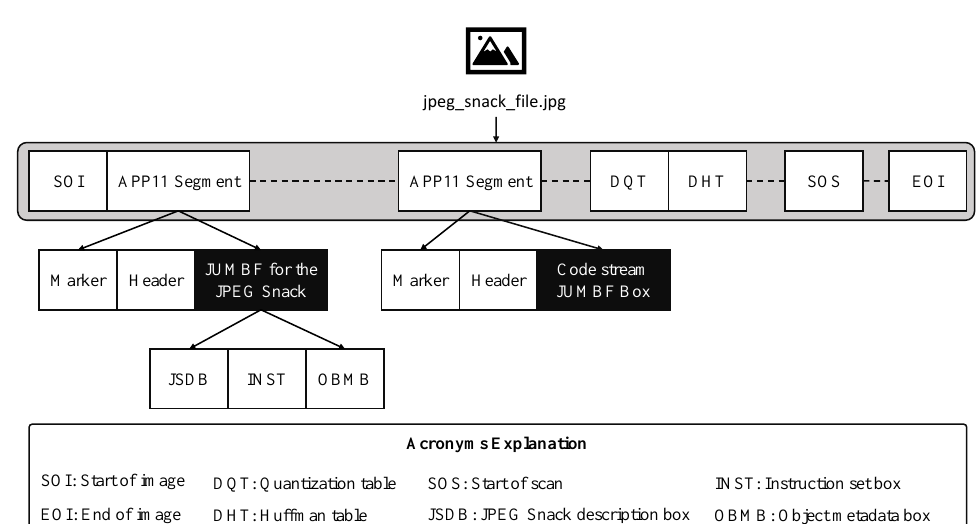
Figure 1. JPEG Snack file organization. Joint photographic experts’ group (JPEG) Snack file having application 11 (APP11) marker and JPEG universal metadata box format (JUMBF) boxes.